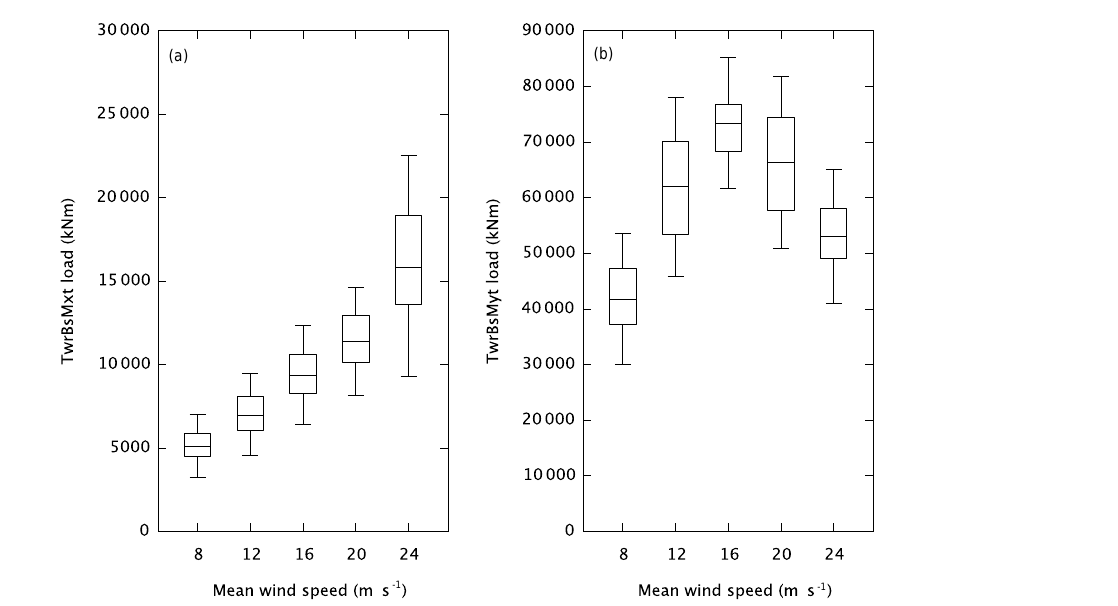
Figure 1. Box-and-whisker plots of the distribution of the raw response (specifically, all 1min maxima) of the combined TurbSim–FAST simulation as a function of wind speed bin for side–side (a) and fore–aft (b) loads. The difference in general trend between side–side and fore–aft loads is clearly evident. The variability within each bin is extreme (especially for the fore–aft load), which puts an upper bound on the utility of sampling methods (e.g., IS) targeting certain wind speeds. The boxes show the median and 25th and 75th percentiles. The whiskers are positioned at the 5th and 95th percentiles. The data are the absolute maxima in 1min segments of 120 separate 10min simulations per bin (1200 total peaks for each